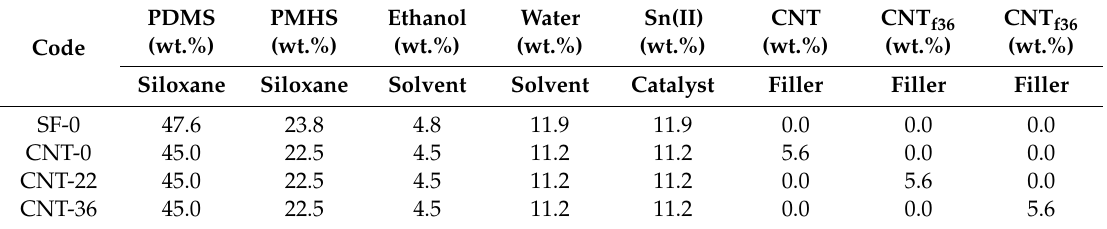
Table 1. Composite solution compositions (carbon nanotubes (CNT): pristine; CNT f22 : degree of